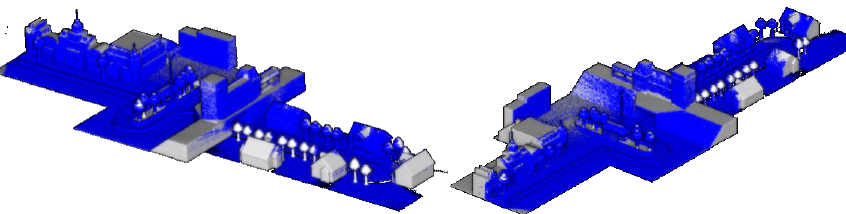
Figure 6. Coverage evaluation where blue color represents the scanned point cloud subtracted out of the simulated reference gray point cloud.